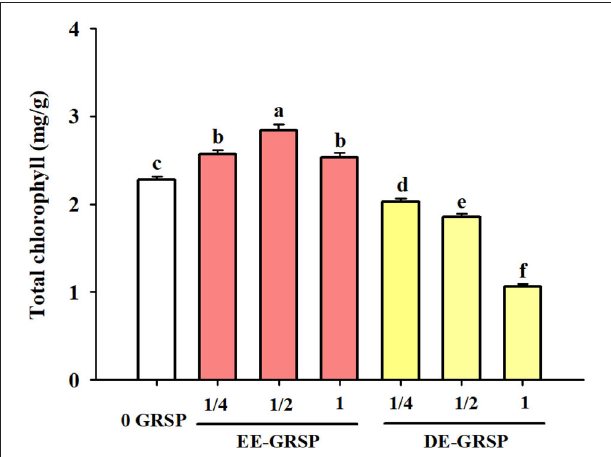
FIGURE 2 | Effects of exogenous EE-GRSP and DE-GRSP on total chlorophyll concentration in leaves of trifoliate orange seedlings. Data (mean ± SD, n = 4) followed by different letters above the bars indicate significant differences ( p < 0.05). DE-GRSP: difficultly extractable glomalin-related soil protein; EE-GRSP: easily extractable glomalin-related soil